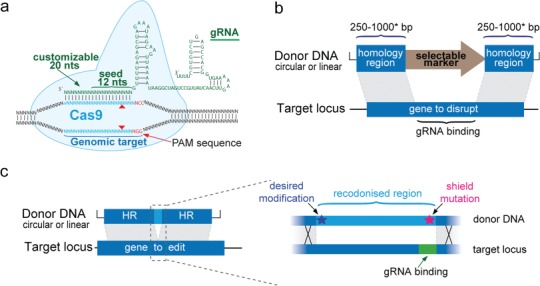
(a) Cas9 is directed to a specific genomic target by the first 20 nt of the gRNA, resulting in the generation of a double-strand break (red triangles). Donor design for (b) a typical gene-disruption experiment in P. falciparum and (c) marker-free genome editing of a point mutation. Silent ‘shield mutations’ prevent Cas9-gRNA cleavage of the edited locus. Additional silent mutations spanning the gap between the shield mutations and the desired modification can be introduced to help drive the repair event beyond the mutation-of-interest.